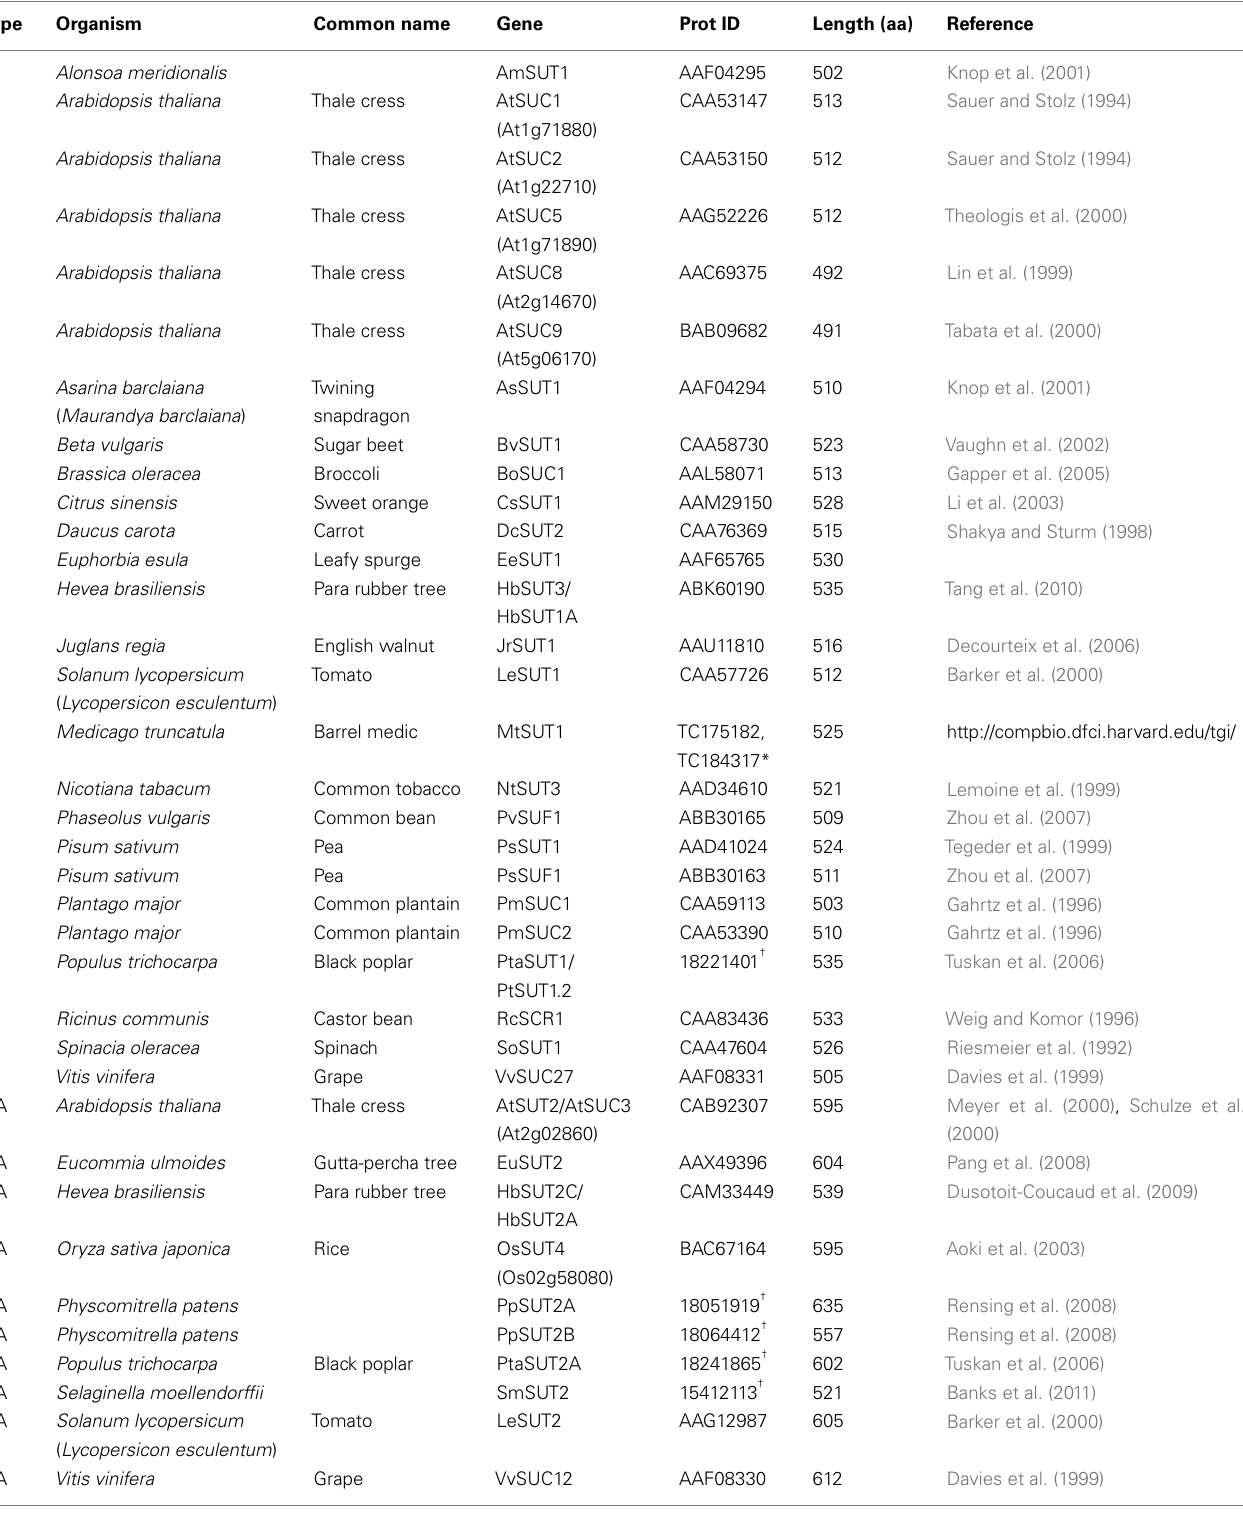
Table 1 | Sucrose transporter